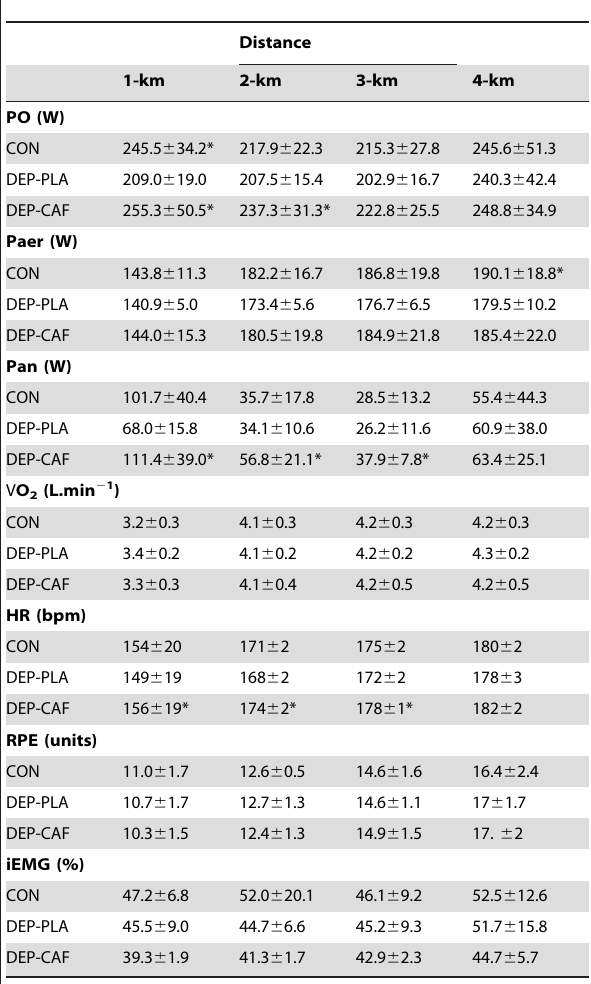
iEMG expressed as percentage of EMG value obtained during MVC. CON: control condition; DEP-PLA: low carbohydrate availability with placebo ingestion; DEP-CAF: low carbohydrate availability with caffeine ingestion. *Significantly higher than DEP-PLA (P , 0.05).